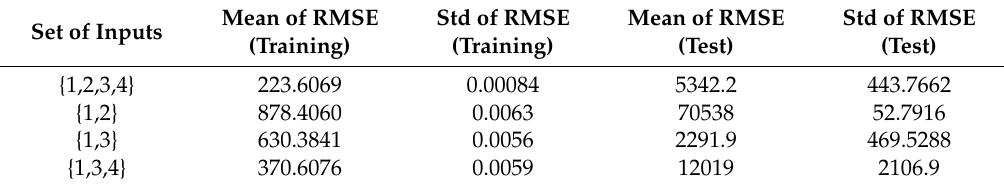
Table 3. Training and test results from LM-BP with different input